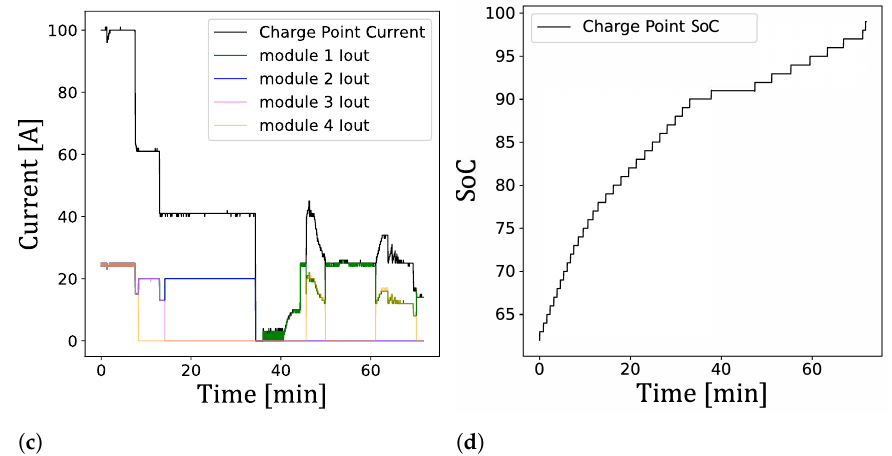
Figure 14. Two Different Endings of Charging Sessions. MINI SE(2020) in ( a , b ) and Hyundai KONA (2019) in ( c , d ).